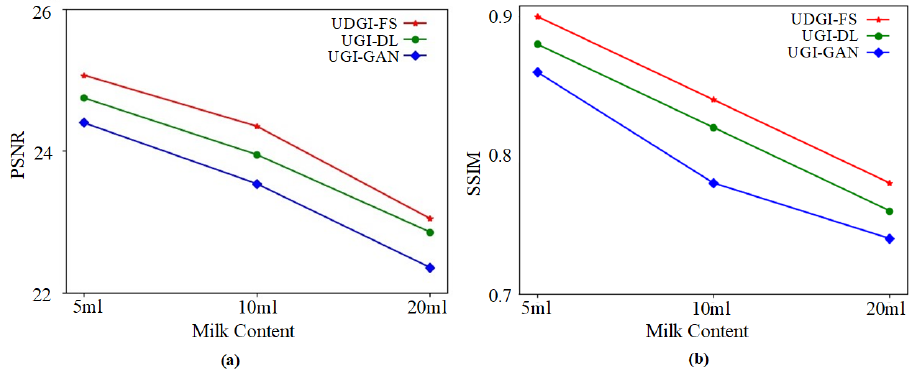
Figure 17. The PSNRs and SSIMs of the reconstructed shark images of UDGI-FS, UGI-DL, and UGI-GAN at different degrees of underwater blurring. ( a ) PSNRs of the reconstructed shark images of UDGI-FS, UGI-DL, and UGI-GAN at different degrees of underwater blurring; ( b ) SSIMs of the reconstructed shark images of UDGI-FS, UGI-DL, and UGI-GAN at different degrees of underwater blurring.